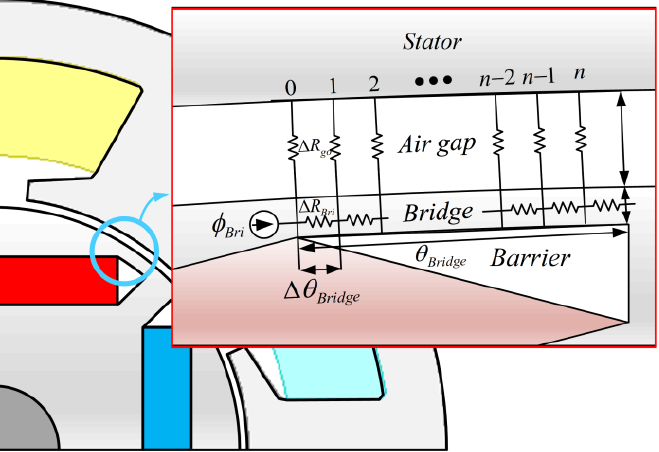
Figure 5. The concept of the reluctance to consider the magnetic saturation of the bridge region of IPM rotor. IPM